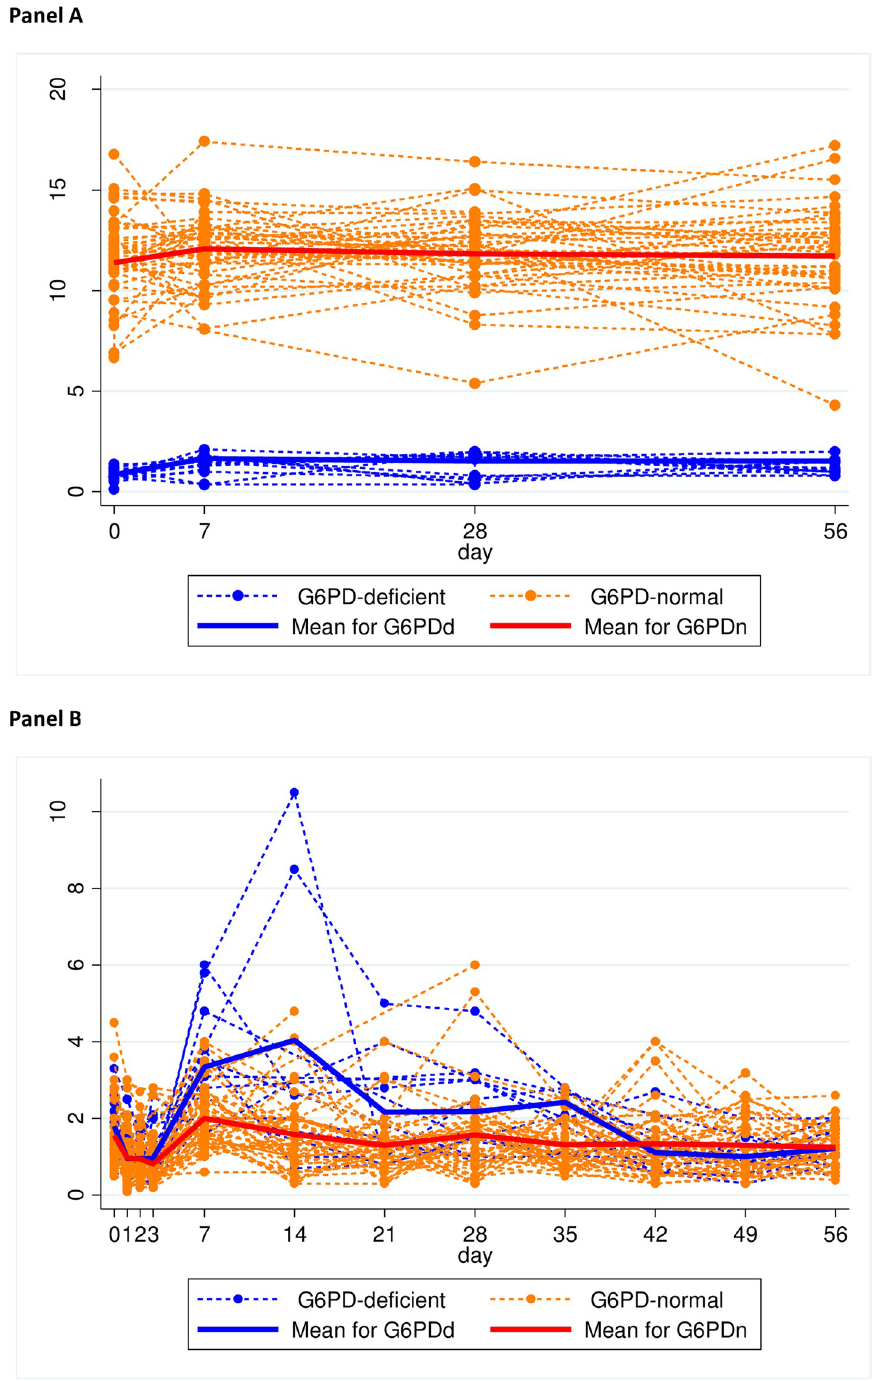
Fig 1. Time course of G6PD activity and reticulocyte counts in male vivax-infected patients given weekly primaquine. Panel A: G6PD activity. Panel B: reticulocyte counts.